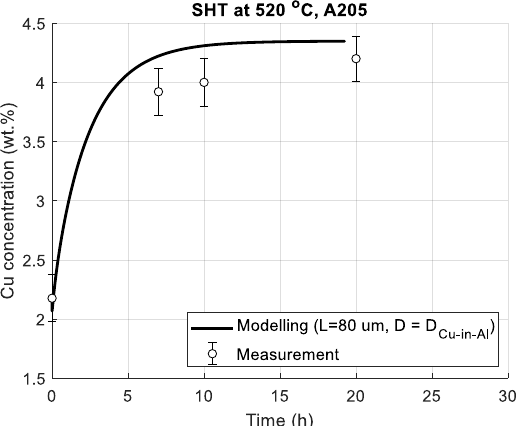
Figure 11. Simulated and measured Cu concentration in the matrix during solution heat treatment at 520 °C for the A205 alloy; the typical value of diffusion coefficient, D Cu-in-Al , from Table 3 is applied in the model.